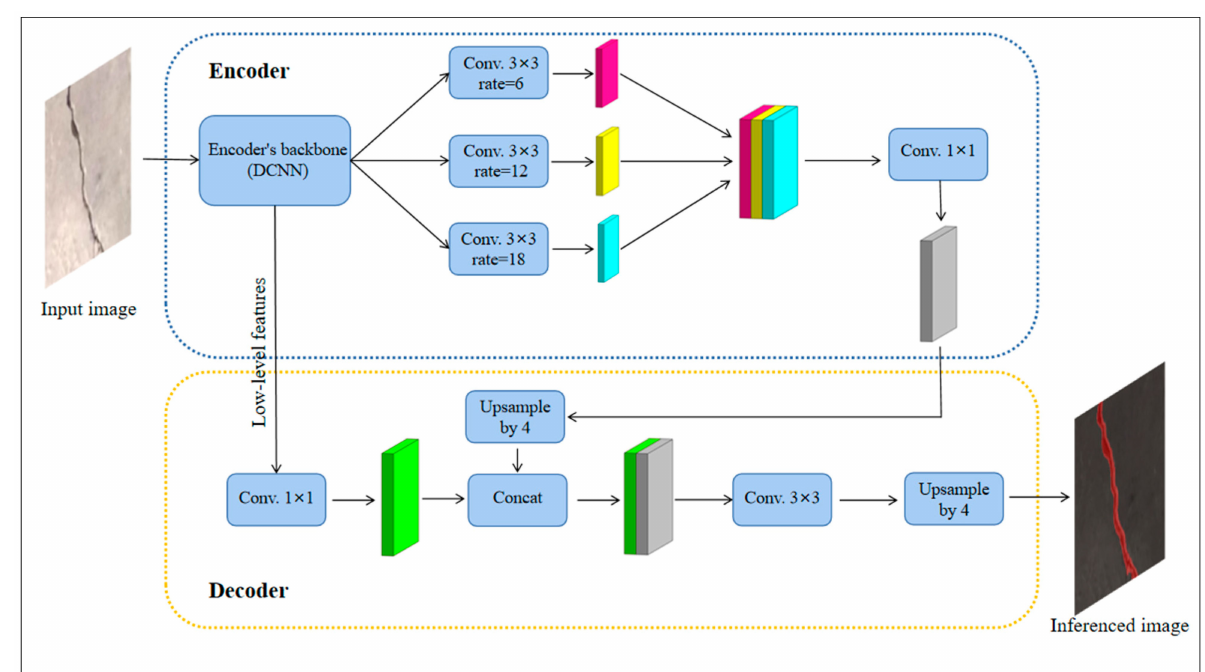
Figure 6. The architecture of DeepLabv3+ in this study.